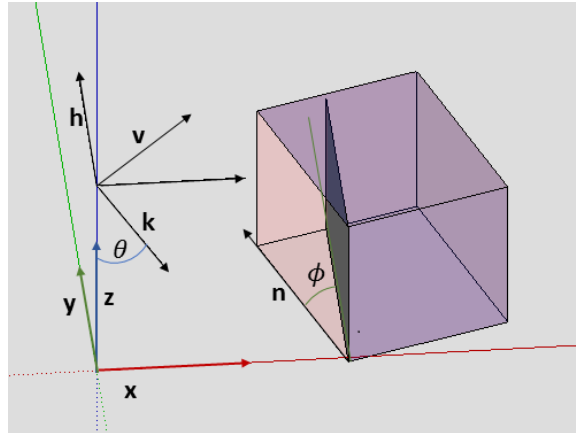
Figure 12. Geometrical notation for computing the relation between azimuth orientation and polarimetric orientation.